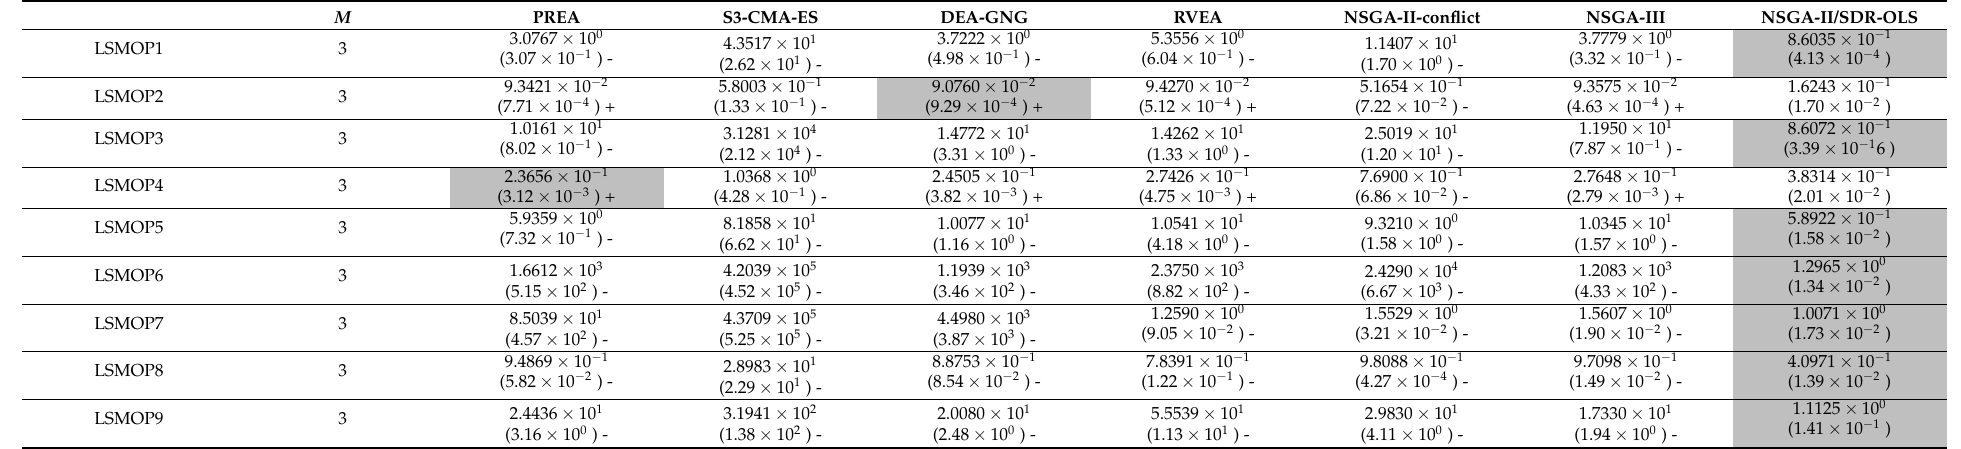
Table 6. IGD values for 9 three-objective benchmark problems.